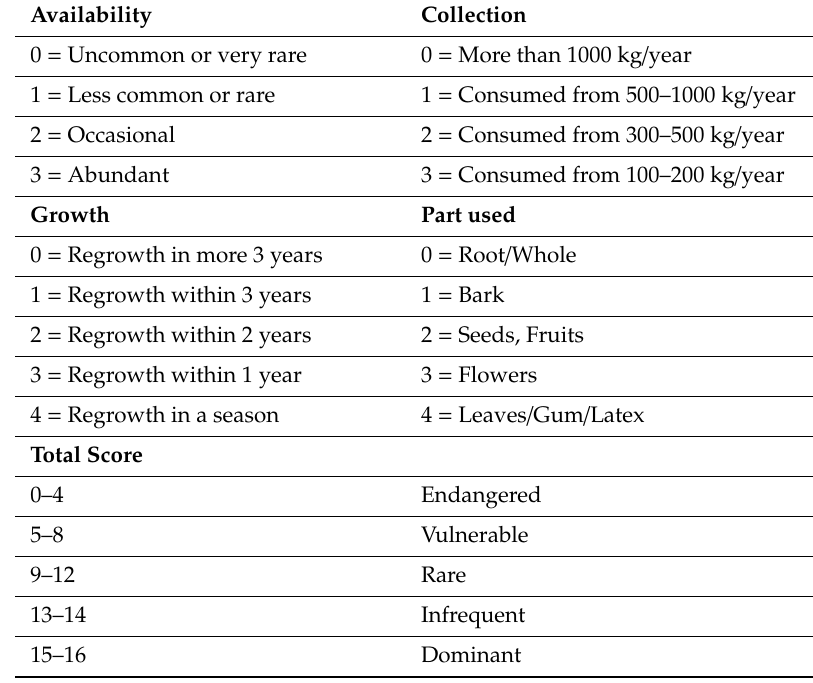
Table 2. IUCN Criteria, 2001 for conservation